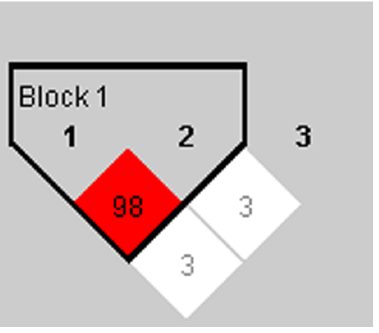
Figure 1. The linkage disequilibrium among 3 SNPs. 1 to 3 represented rs3757385, rs752637 and rs11761199 respectively, and rs3757385 and rs752637 formed a haplotype block by LD analysis.